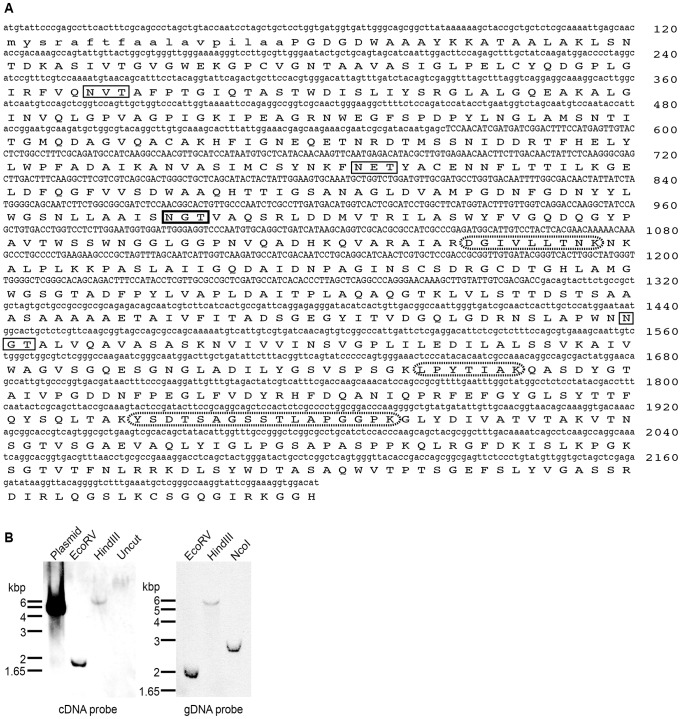

C. raphigera β-glucosidase, D2, is encoded by a single gene.(A) cDNA and amino acid sequences of C. raphigera D2. Upper case DNA sequence indicates the region used as a Southern blotting probe (738–1025bp). Amino acid sequence shown in lower case letters indicates putative signal peptide. Solid box, consensus amino acids for a predicted N-glycosylation site (box with thicker lines indicates the most probable N-glycosylation site). Dotted ovals, common peptides identified by MS in both large and small native D2. (B) Southern blotting of C. raphigera genomic DNA. Left, C. raphigera genomic DNA was cut with indicated restriction enzymes and probed with a PCR-amplified region using genomic DNA as a template. Right, C. raphigera genomic DNA was cut with indicated restriction enzymes and probed with a PCR-amplified region using cDNA as a template.